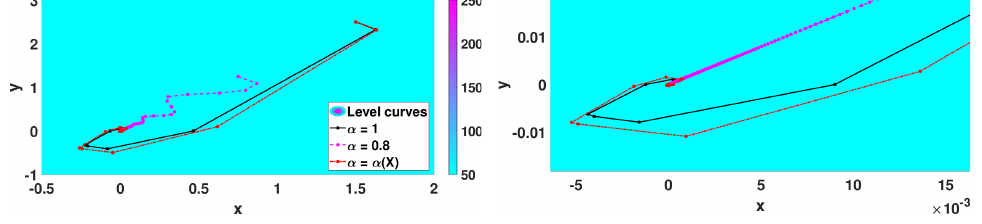
Figure 7. Iterates for f 1 ( Ψ 1 ( X )) .